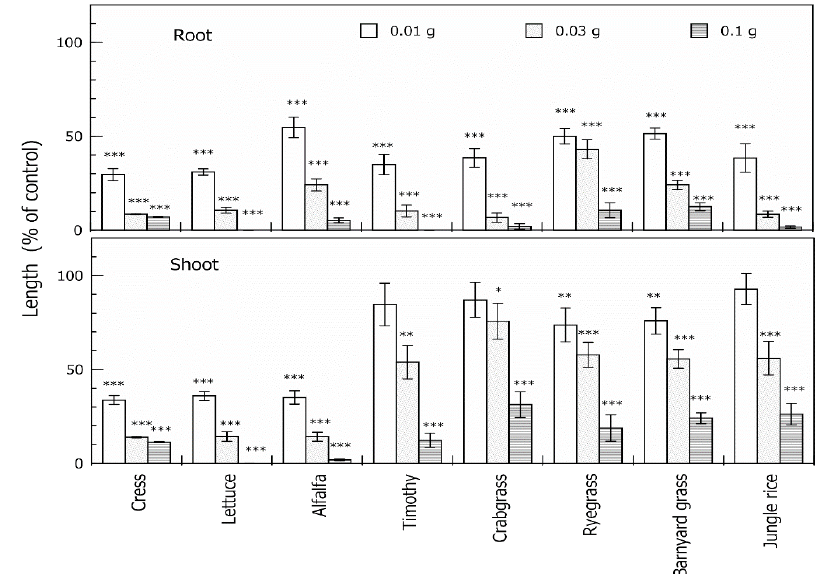
Figure 1. Effects of aqueous methanol extracts of neem leaves on root and shoot growth of cress, lettuce, alfalfa, timothy, crabgrass, ryegrass, barnyard grass and jungle rice . Concentrations of tested samples corresponded to the extract obtained from 0.01, 0.03 and 0.1 g dry weight of neem leaves per mL. Means ± SE from four independent experiments with 10 plants for each determination are shown. Asterisk indicates significant difference between control and treatment: * p < 0.05, ** p < 0.01, *** p <